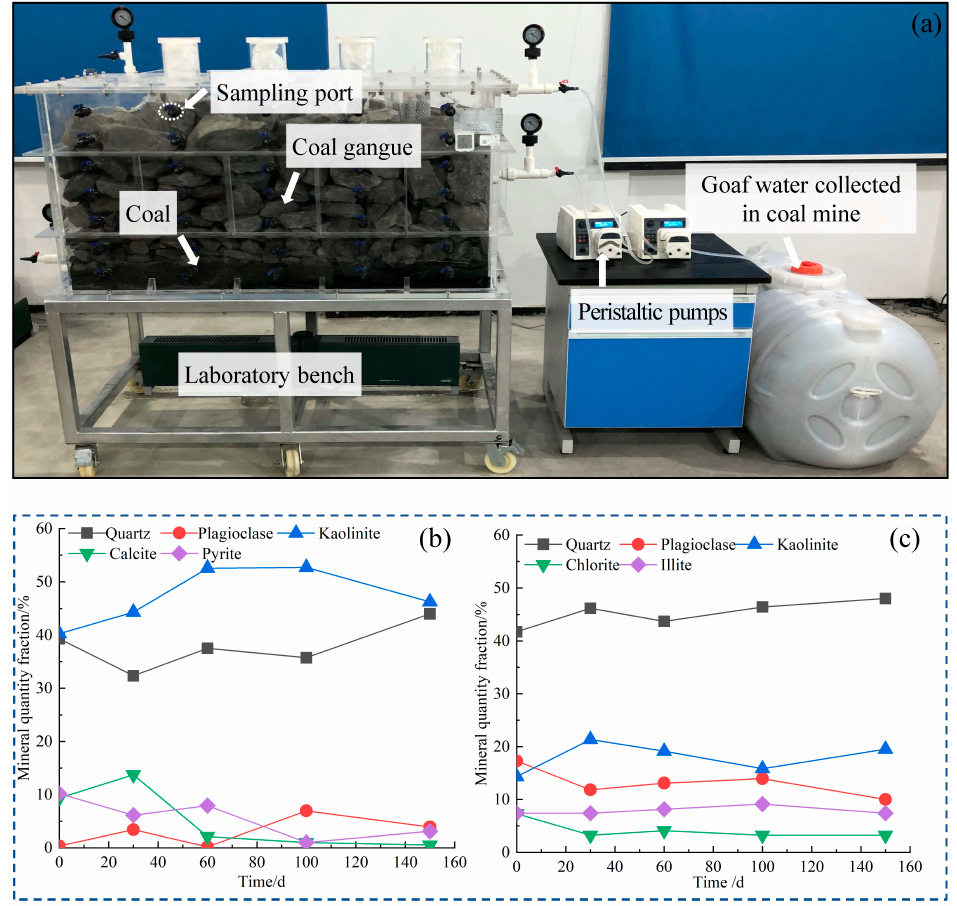
Figure 10. Experimental tests ( a ) experimental setup; ( b ) change in mineral mass of coal; ( c ) change in mineral mass of coal